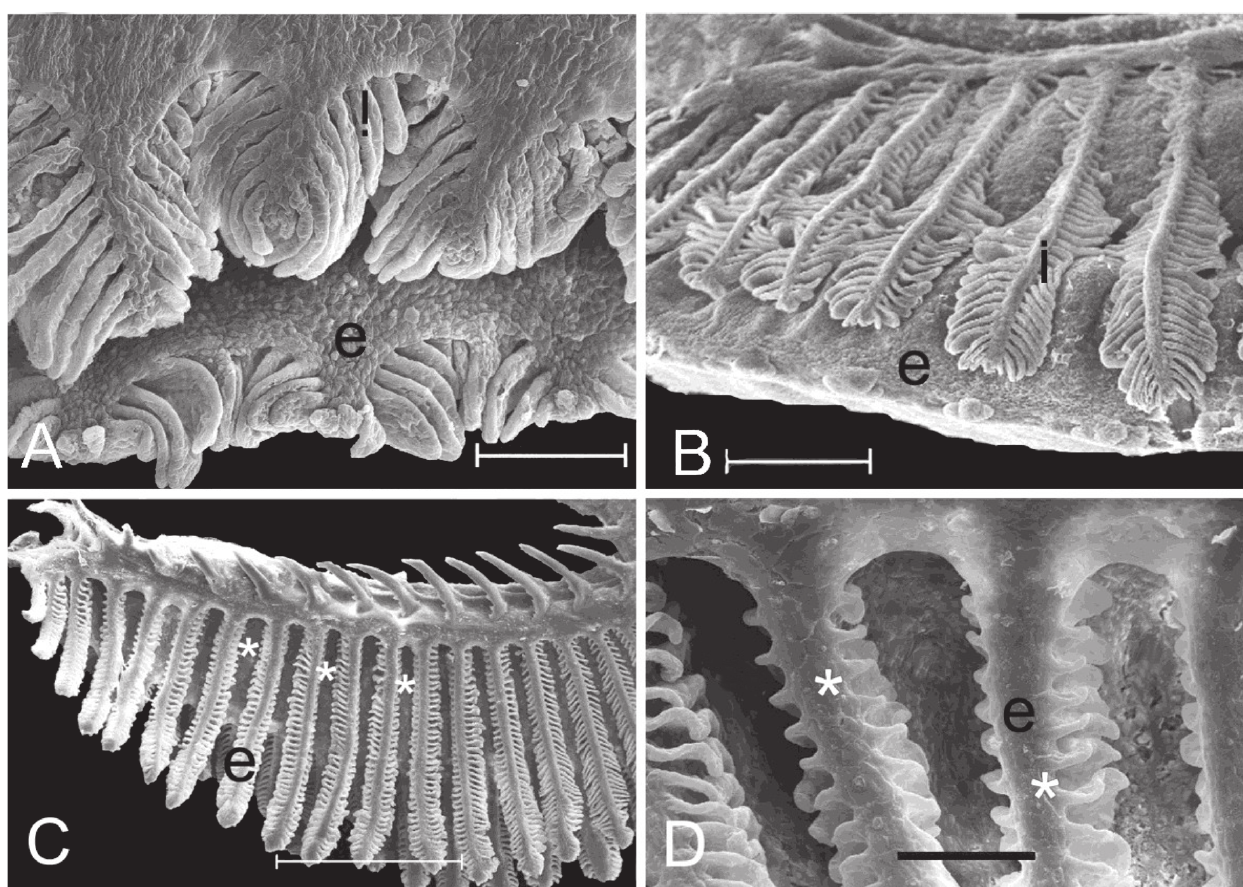
Fig. 6. Scanning electron micrograph of gill arches. A ) Lateral view of first gill arch of Compsura heterura , with gill glands occupying both hemibranchs, both with the same extension. Scale bar: 100 µm. B ) Medial view of first gill arch of Kolpotocheirodon theloura , with gland of external hemibranch embracing internal filaments. Scale bar: 200 µm. C ) Lateral view of second gill arch of Saccoderma hastata. In Saccoderma hastata , the glands may be in the external (e) or internal hemibranch (i and asterisks) of the second gill arches. Scale bar: 500 µm. D ) Detail of micrograph C. Scale bar: 100